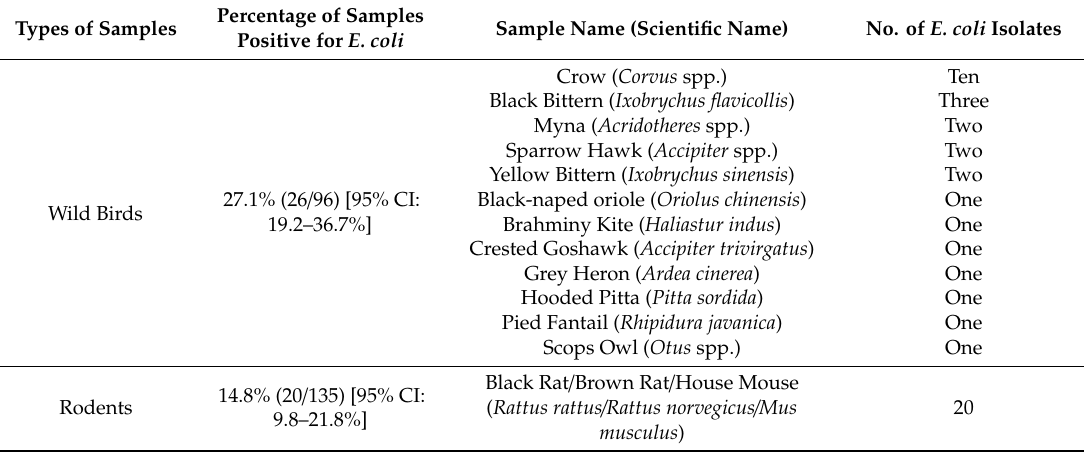
Table 2. Occurrence of E. coli in wild birds and rodents.